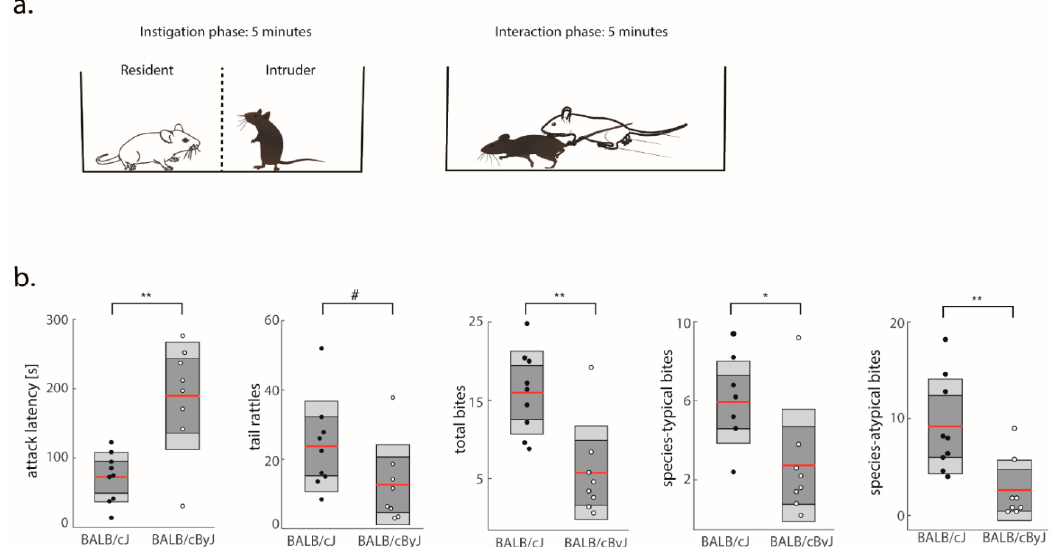
Figure 1. Behavioral metrics of aggression: ( a ) Schematic of the RI test. Testing started with a 5 min instigation phase (mice separated by a glass screen), followed by a 5 min interaction phase; ( b ) Average attack latency, total number of bites, tail rattles, species-typical bites, and species-atypical bites. Black dots, BALB/cJ mice; gray dots, BALB/cByJ mice. Shown are average (red line), 95% confidence interval (dark gray area), and 1 SD (light gray area). # p < 0.1, * p < 0.05; ** p < 0.01.